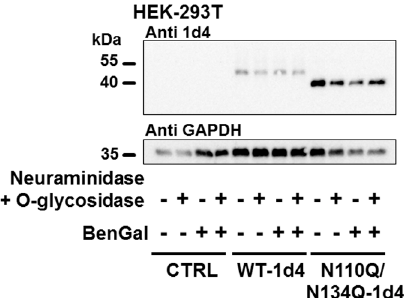
Figure 6. There is no evidence for O -glycosylation of hTREK-1 channels. Immunoblots of hTREK-1 are shown for control conditions, after administration of the O -glycosylation inhibitor benzyl 2- acetamido-2-deoxy- α - D -galactopyranoside (BenGal) and after incubation of the protein lysates with a mixture of O -glycosidase and neuraminidase (to yield potential O -glycosides accessible to O -